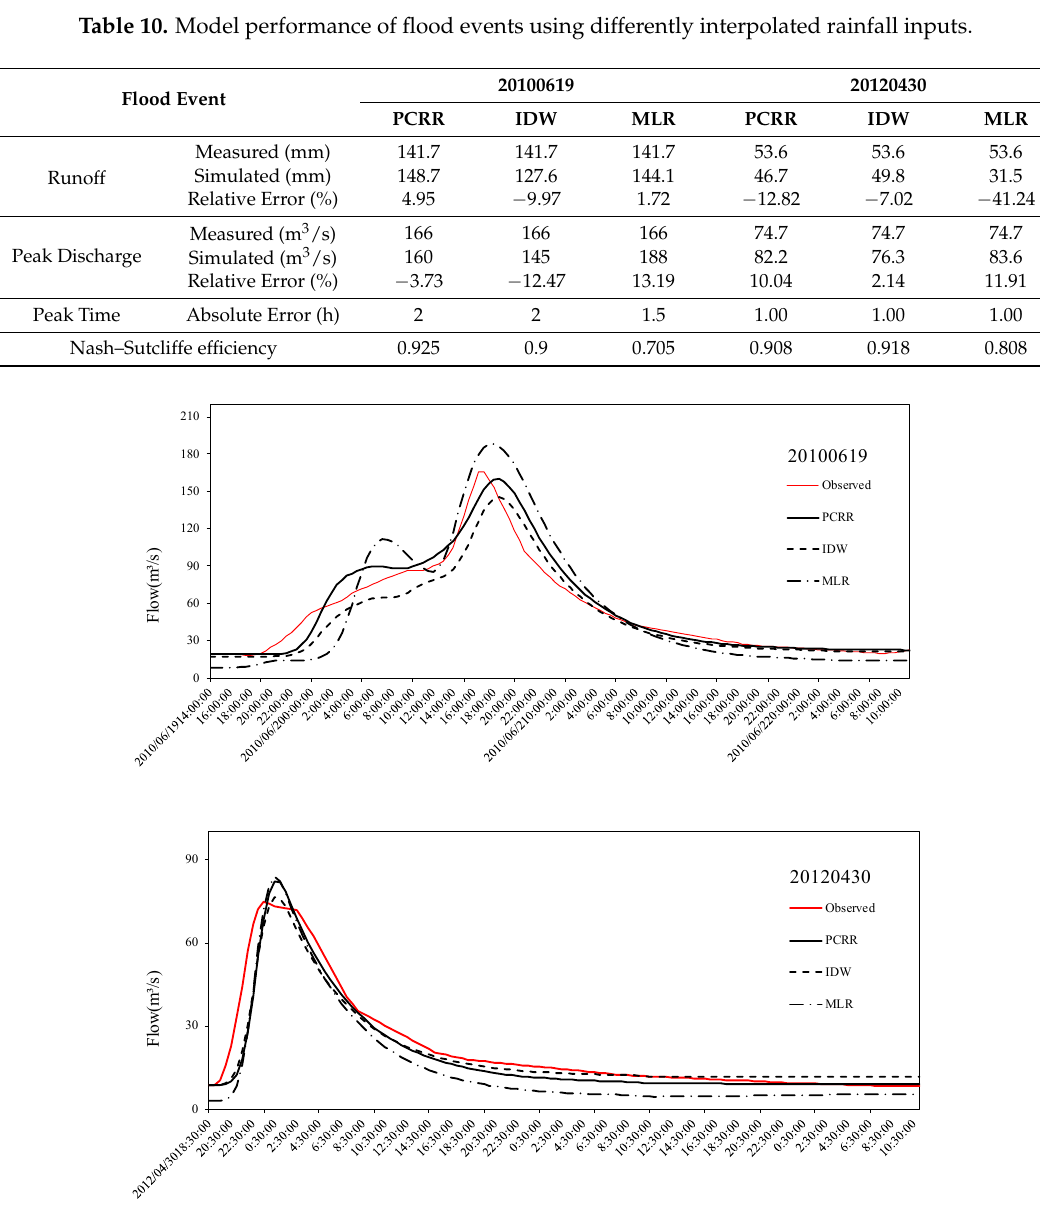
Figure 7. Modeled and measured runoff of two flood events in Xinxie catchment for PCRR, IDW, and MLR rainfall interpolation.